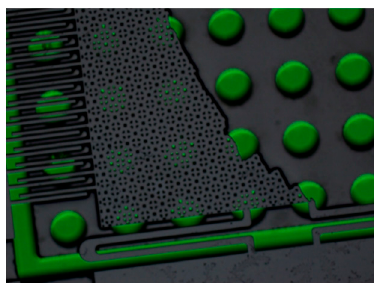
Figure 12. The proof mass and the bottom structure are stuck together.